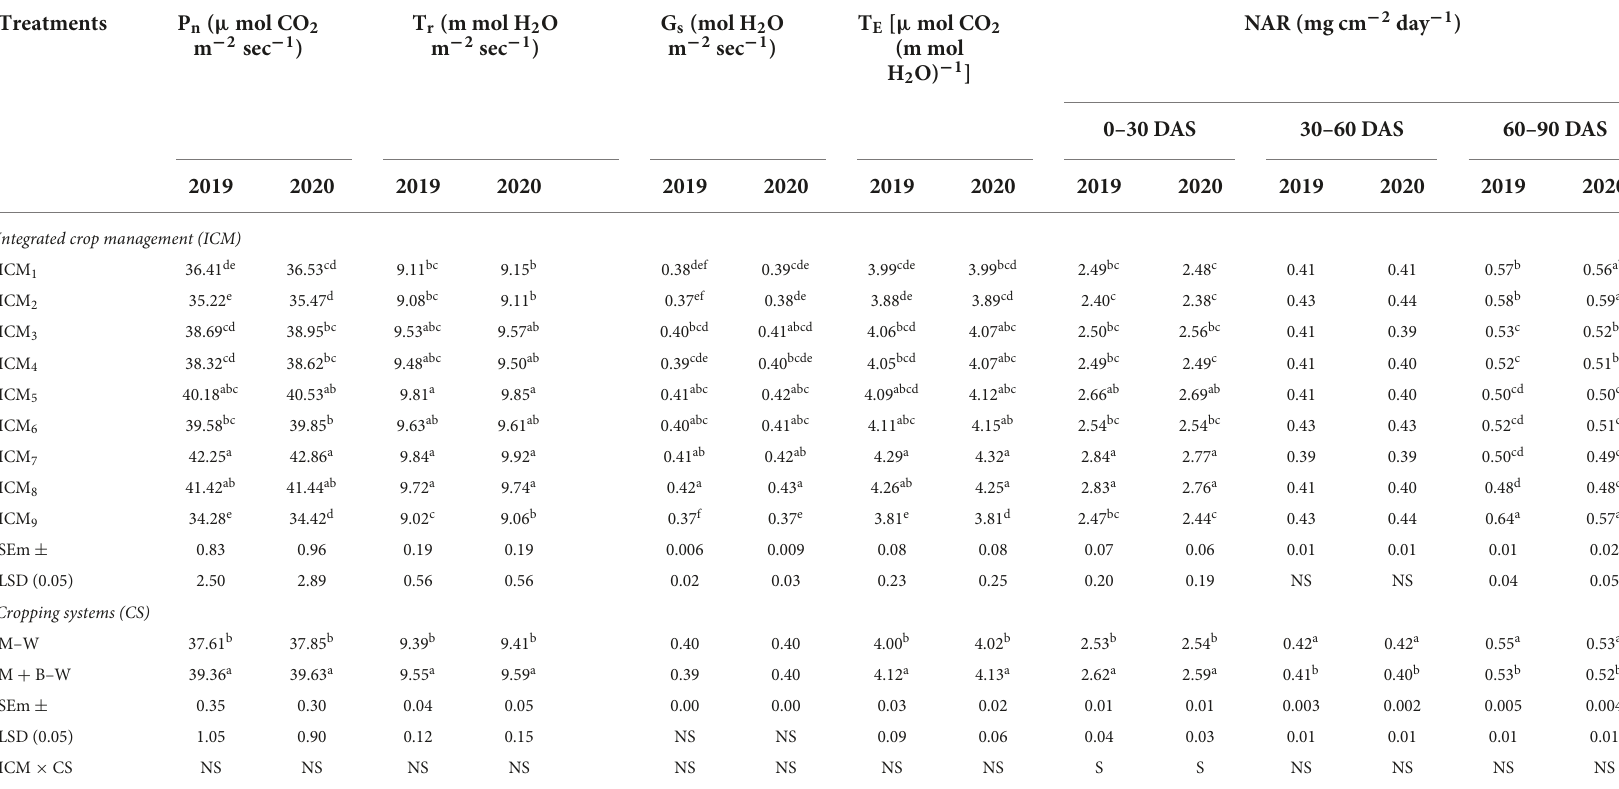
TABLE 3 Effect of ICM modules and cropping system on net photosynthetic rate (Pn), transpiration rate (T r ), stomatal conductance (G s ), transpiration efficiency (T E ) at flowering stage and net assimilation rate (NAR) at 30-day intervals in maize a .